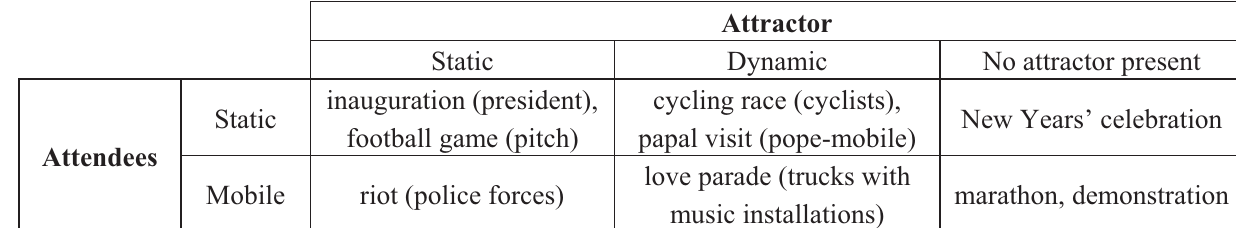
Table 1. Characterization of crowd scenarios according to the mobility of the attendees and the presence/mobility of an attractor. The attractors for the specific examples are shown between